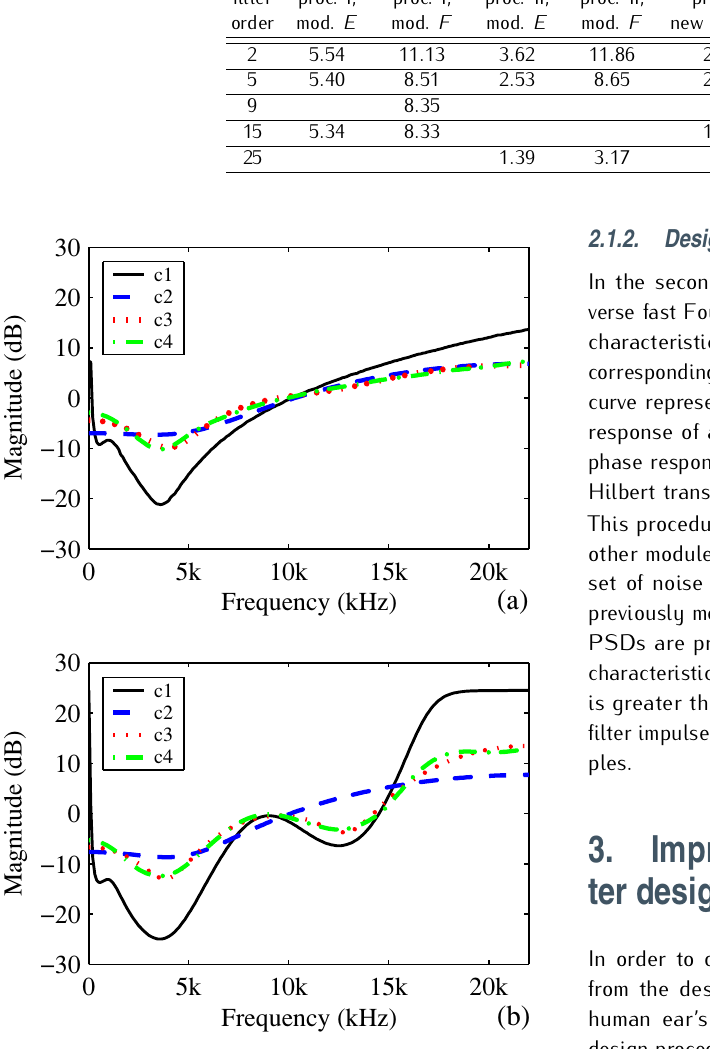
Figure 2. The design curves (c1) – modified E (a) and modified F (b) together with PSDs of the filters of 2 nd (c2), 5 th (c3) and 15 th (c4) order designed by the procedure